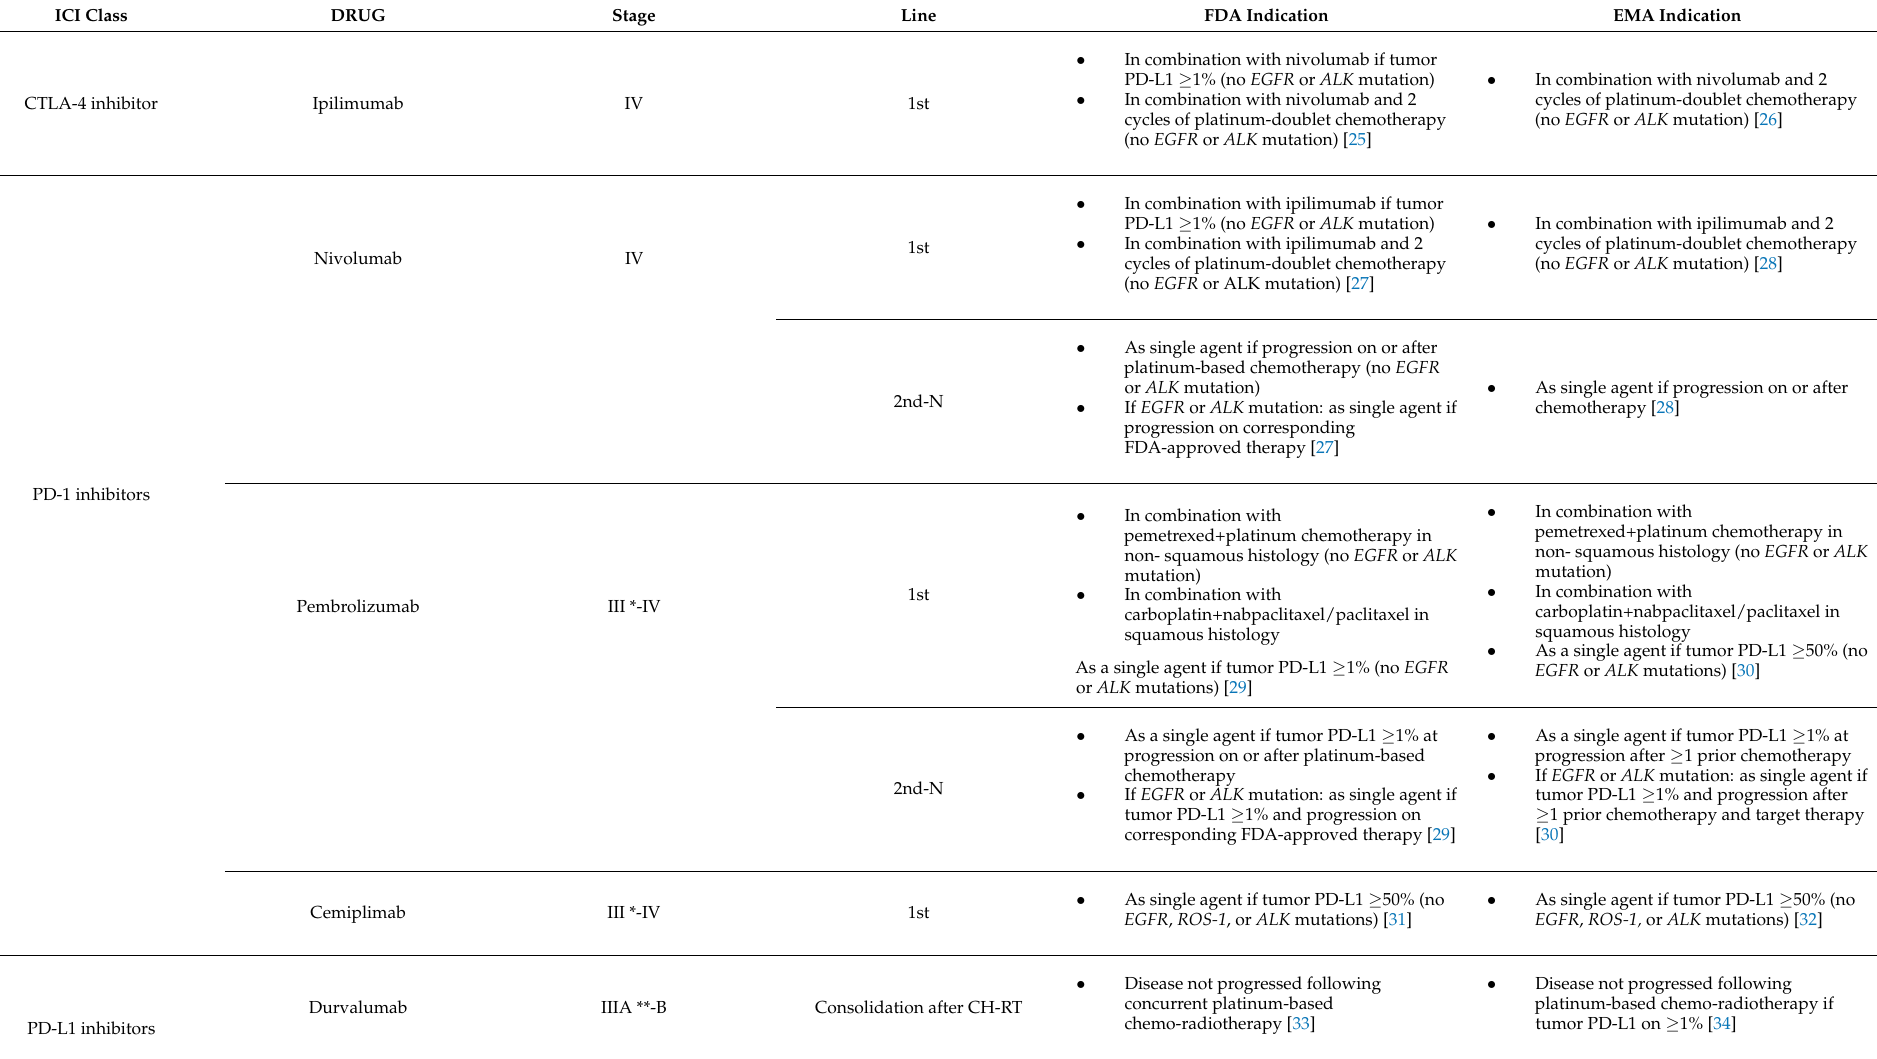
Table 1. Summary of the FDA- and EMA-approved immune checkpoint inhibitors for non-small cell lung cancer (NSCLC)